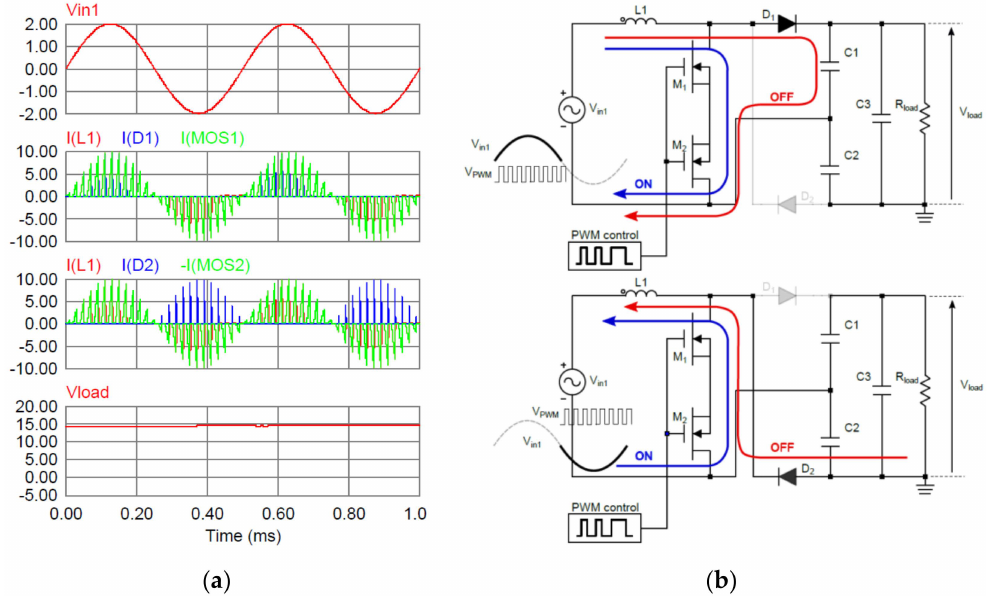
Figure 26. Waveforms and states of a Split N converter obtained with PSIM. ( a ) Current waveforms and output load voltage. ( b ) States of devices and current